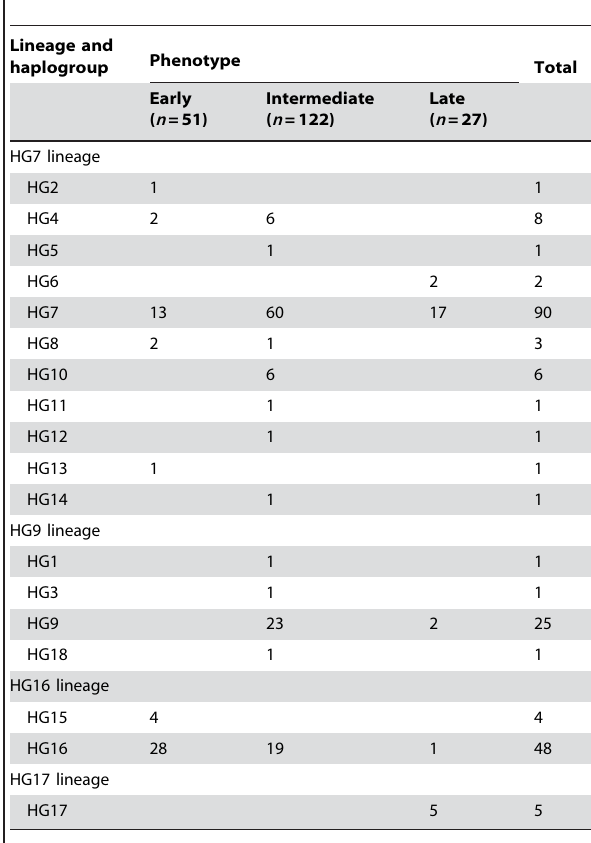
Table 2. Genealogical structure of flowering time